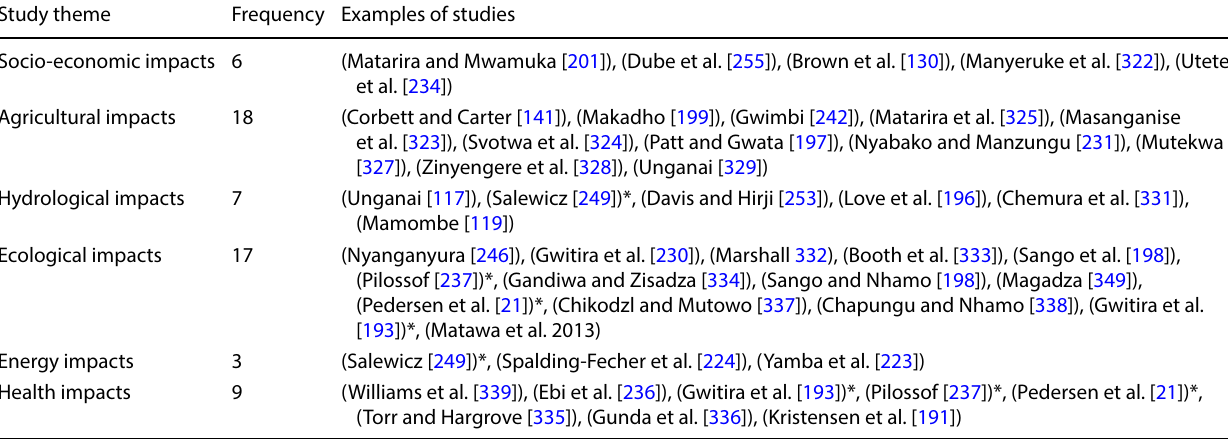
Table 3 Summary table showing climate impact studies categories and study examples done in Zimbabwe from 1990 to 2019 ( n = 52)